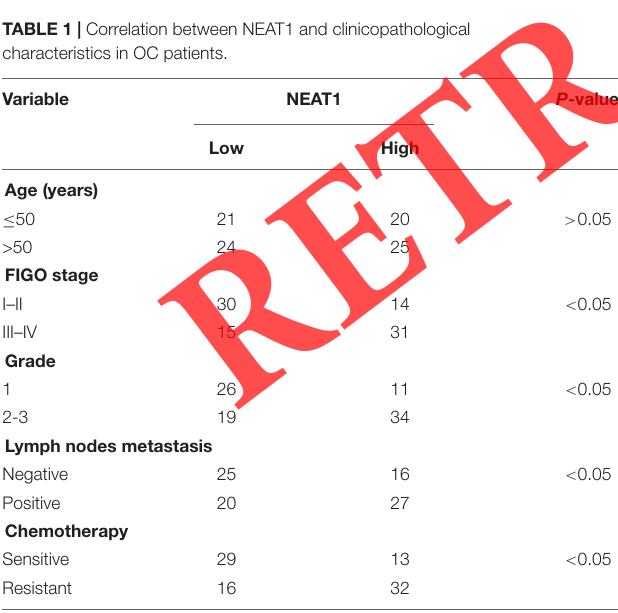
FIGURE 1 | NEAT1 was upregulated in cisplatin-resistant OC. (A) QRT-PCR analysis of NEAT1 expressions in OC or adjacent normal tissues. (B) Relative NEAT1 expression in cisplatin-resistant OC and cisplatin-sensitive OC. (C) Kaplan-Meier curve of the estimated overall survival of both low and high NEAT1 expression groups. (D,E) Relative NEAT1 expression in both cisplatin-resistant and cisplatin-sensitive OC cell lines. Data were reported as mean ± SD. * p < 0.05, ** p < 0.01, *** p < 0.001.